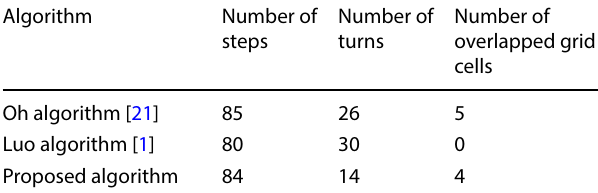
Table 9 Comparison studies for a single robot system